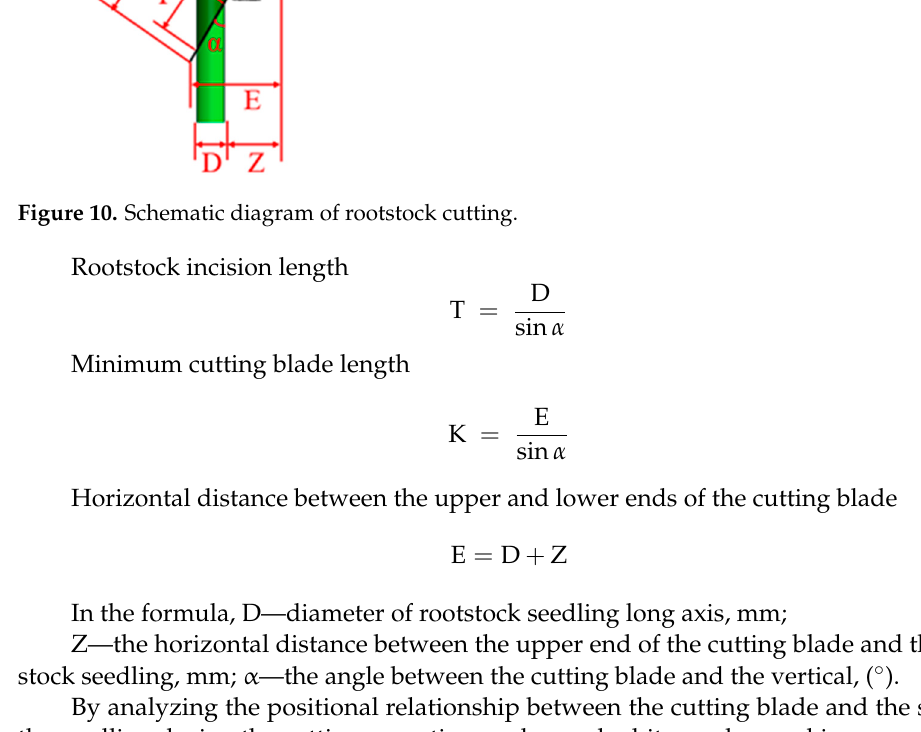
Figure 10. Schematic diagram of rootstock cutting.